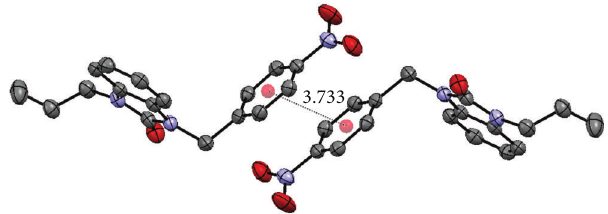
oc a Figure 7: Molecular packing in the unit cell showing four molecules in the asymmetric